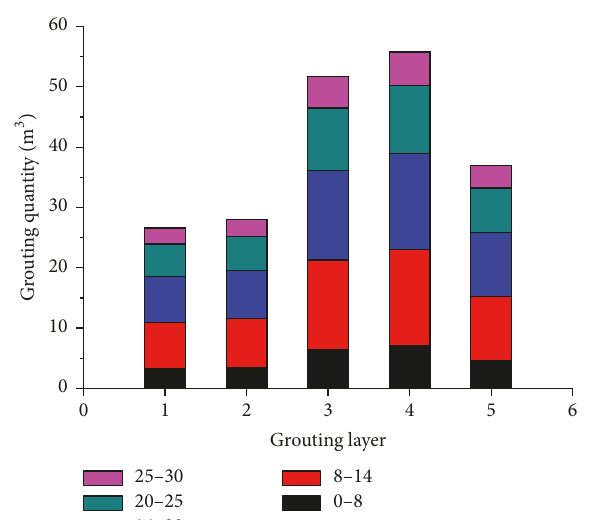
Figure 19: Section grouting quantity.